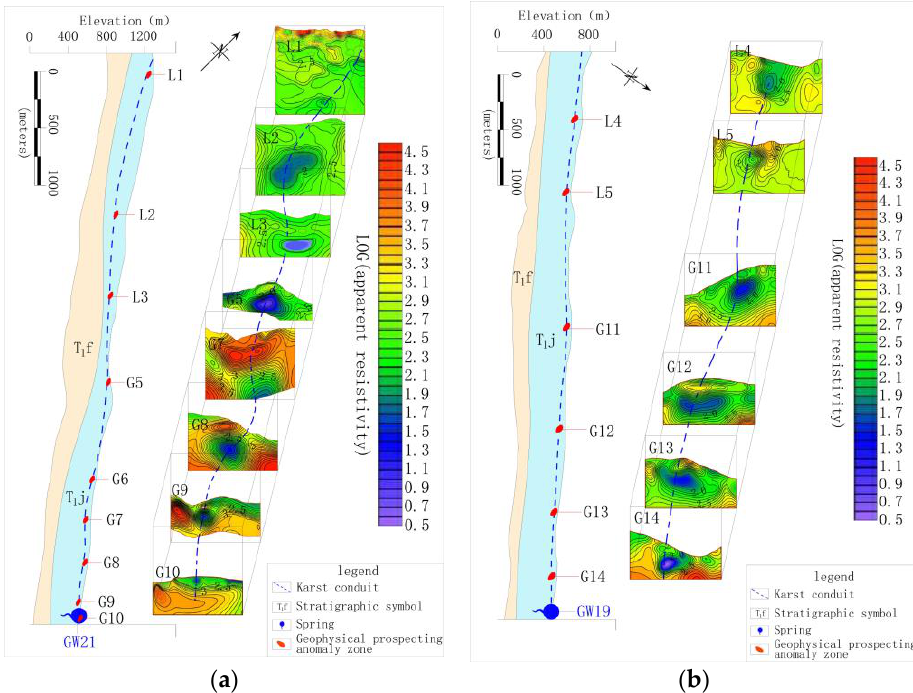
Figure 2. ( a ) Interpretation of geophysical survey section of 9 karst conduit; ( b ) interpretation of geophysical survey section of a 12karst